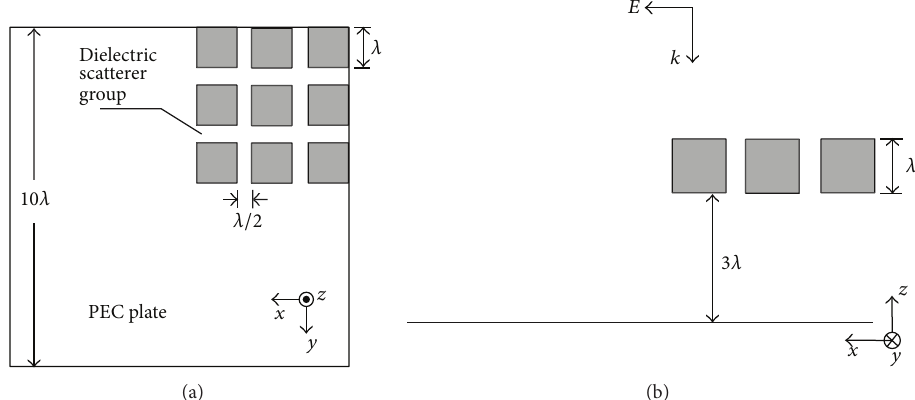
Figure 3: (a) Top view and (b) side view of the scatterer group of 3 × 3 dielectric bodies set above the electrically large PEC